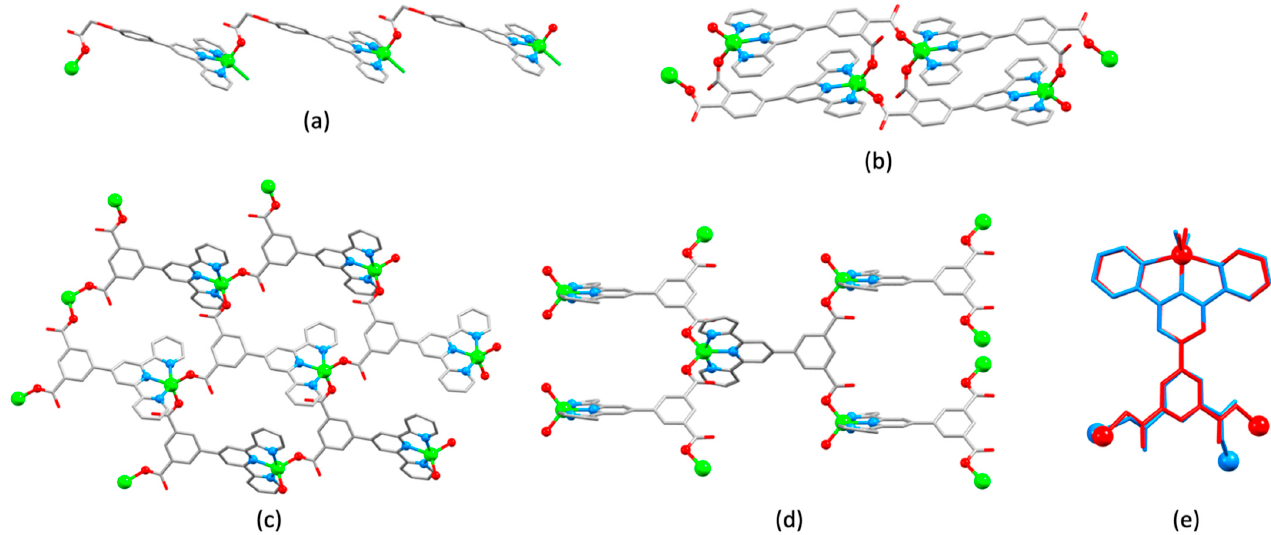
Figure 6. Parts of the 1D ‐ coordination polymers in (a) [ZnCl( 5 )] n . 0.5 n H 2 O (CSD refcode FUJBET), and (b) [Zn( 8 )] n (refcode HOGYIO). (c) Part of the 2D ‐ network in [Zn( 9 )] n . n H 2 O (CSD refcode KEGTAU) and (d) part of the 3D ‐ net in [Zn( 9 )] n . 2 n MeOH . n NMP (CSD refcode KEGTEY, NMP = N ‐ methyl ‐ 2 ‐ pyrrolidone). (e) An overlay of the building ‐ block in each of [Zn( 9 )] n . n H 2 O (blue) and [Zn( 9 )] n . 2 n MeOH . n NMP (red) with Zn atoms in ball ‐ representation showing the differ ‐ ences in the O–Zn vectors (bottom of the diagram).